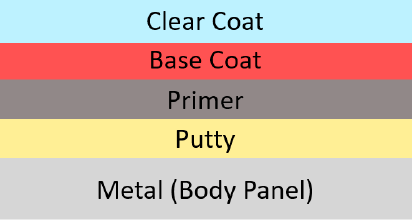
Figure 1. Automotive refinish coating layers applied over the body panel